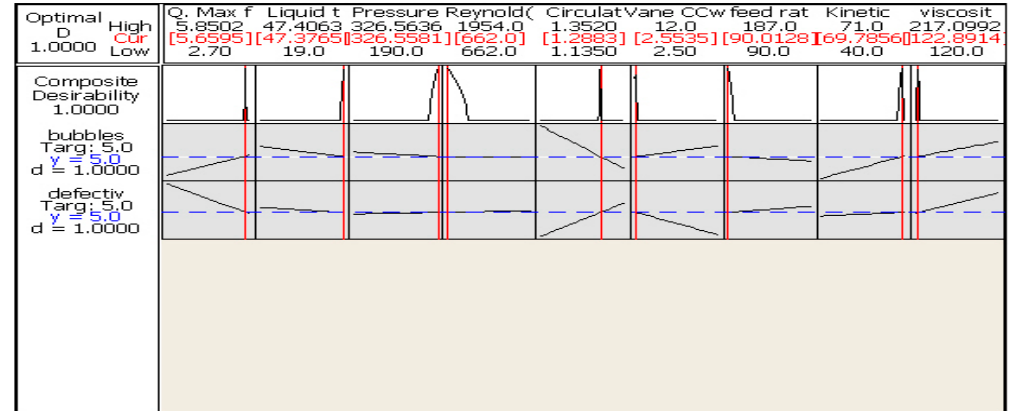
Figure 28. Optimum values of influencing factors controlling bubble movement to reduce defects.